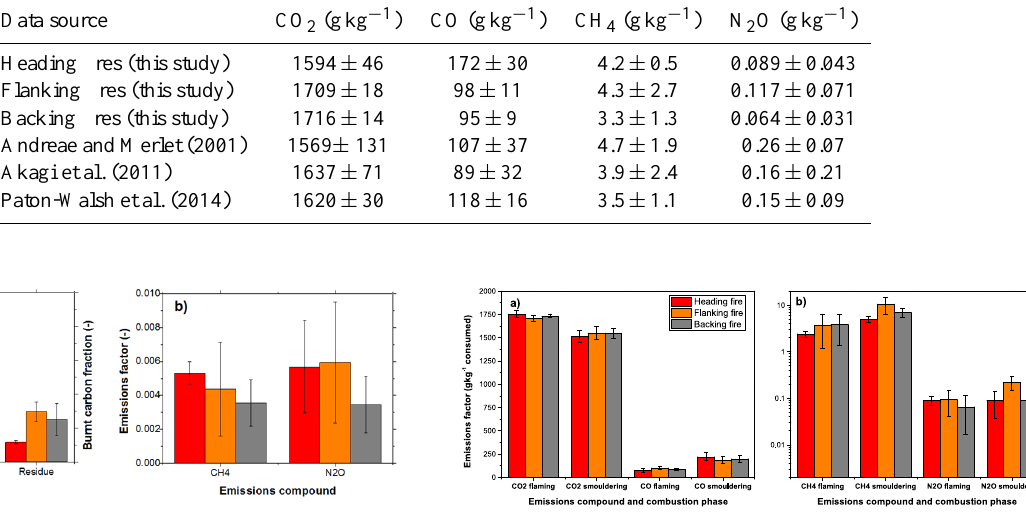
Figure 7. Carbon and nitrogen based emissions factors (per unit of carbon or nitrogen burnt) and burnt carbon residue fractions from the experimental burns: (a) CO 2 , CO and residue carbon emissions factors; (b) CH 4 and N 2 O emissions factors.